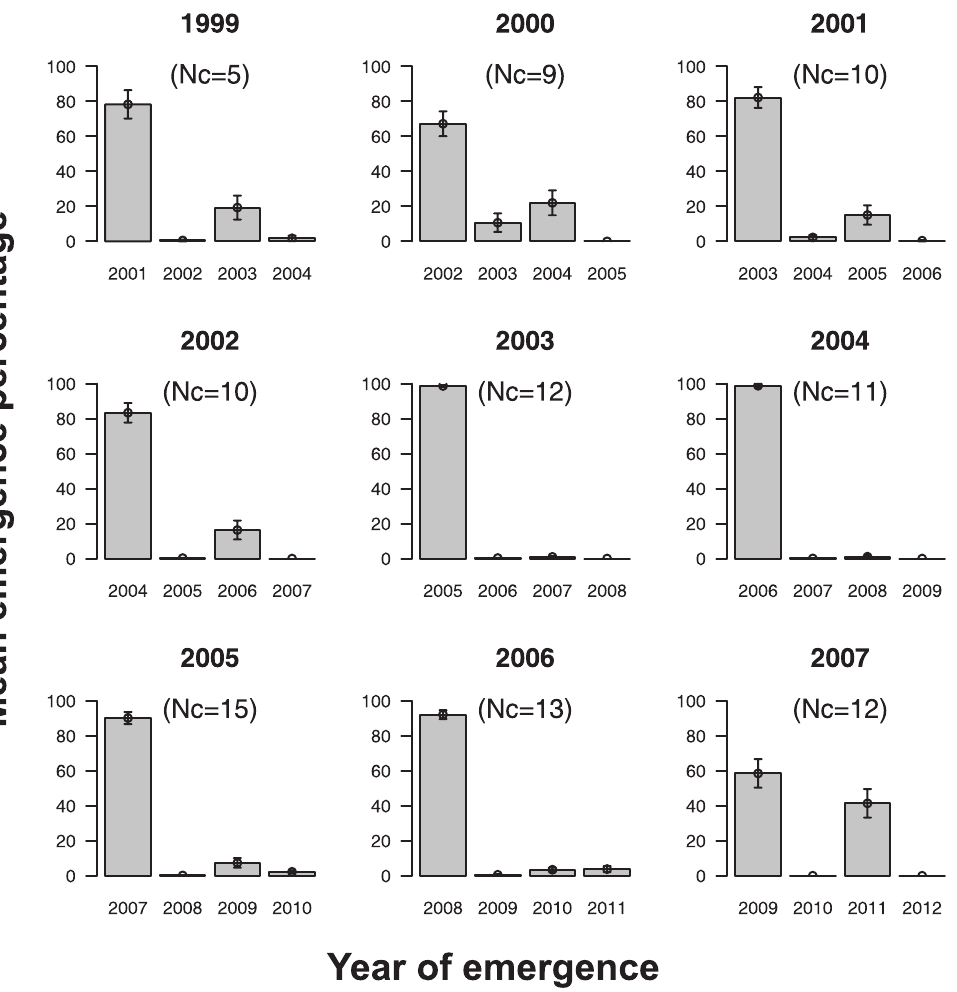
Figure 2. Adult emergences from seeds of C.atlantica in southern French cohorts of M.schimitscheki over the five consecutive years following their productions (1999–2007). Emergences occurring beyond the 2-year obligatory diapause due to host cone maturation reflect propensities to prolonged diapause. Nc: number of cohorts surveyed per year of production on which mean emergence percentages and their standard errors (bars) were estimated. In 2008, only one population (Mont Ventoux) was surveyed for genetic purposes (Table 2).